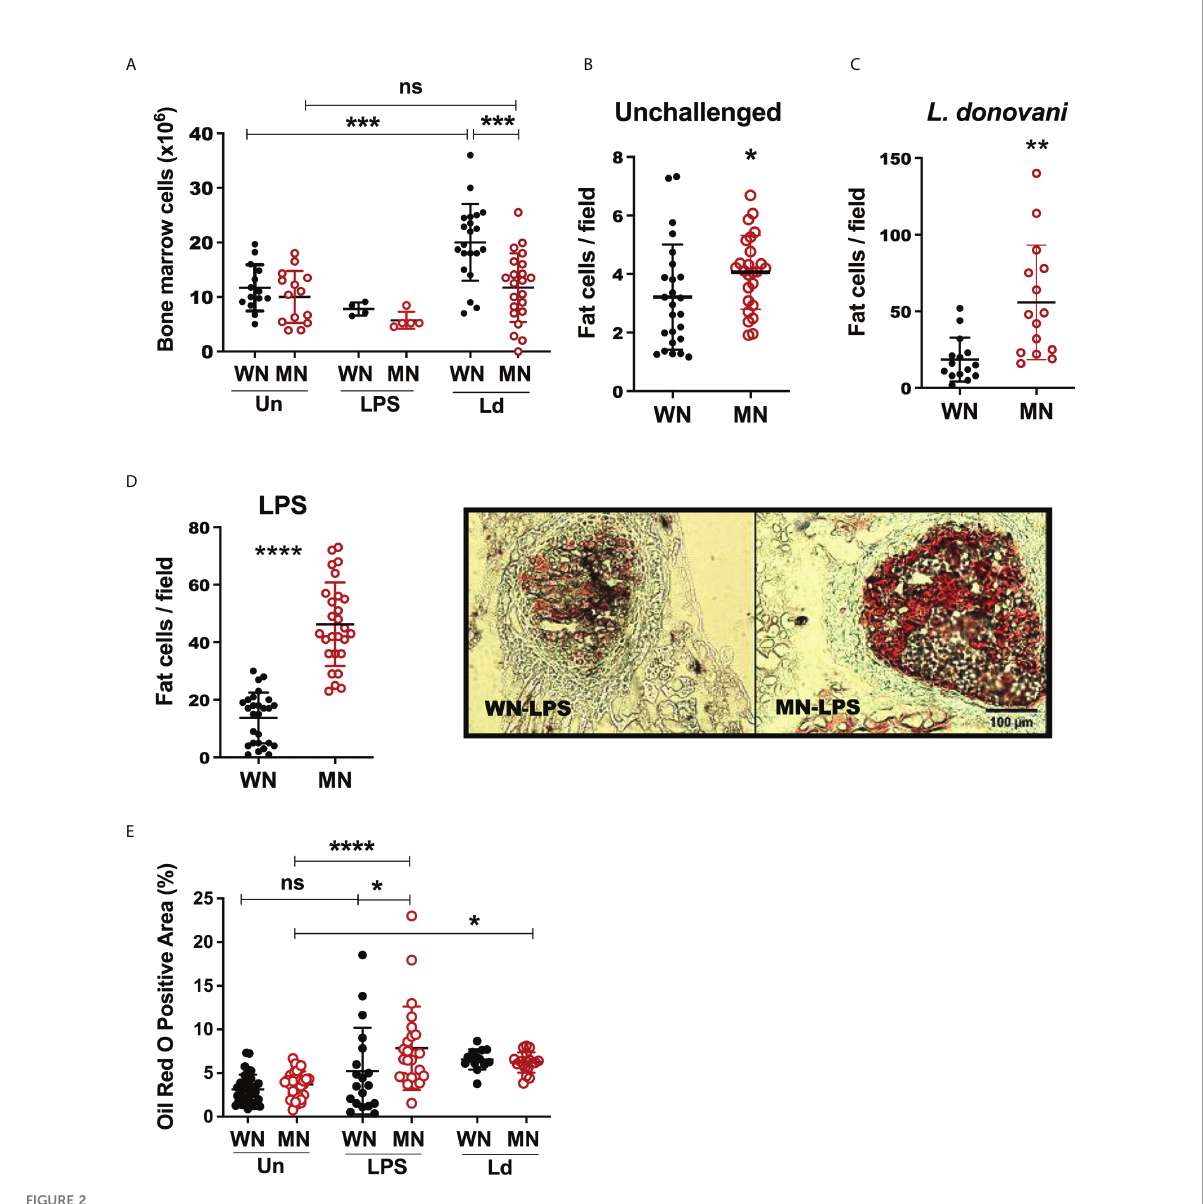
FIGURE 2 Malnutrition leads to increased bone marrow adiposity. Well-nourished (WN) or malnourished (MN) mice were challenged with lipopolysaccharide (LPS) or L. donovani ( Ld ) and compared with naïve unchallenged (Un) mice. L. donovani -challenged mice were evaluated at 72h post-challenge and LPS-challenged mice were evaluated at 24h post-challenge. (A) Number of cells in bone marrow from femur enumerated by microscopy. (B) Number of lipid- fi lled Oil-Red O positive (Oil-red O+) cells in sternum cryosections from uninfected mice. (C) Number of cells Oil-Red O positive (Oil-red O+) in sternum cryosections from L. donovani challenged mice at 72h post-challenge. (D) Left panel: Number of Oil-Red O+ bone marrow cells per fi eld in sternum cryosections from LPS-challenged mice. Right panel: image showing Oil- red O+ cells in hematopoietic centers observed in sternum cryosections from LPS challenged mice. (E) Oil-Red O+ area (hematopoietic centers + bone areas) in sternum cryosections. N=5 mice per group, 2 experiments. *p<0.05, **p<0.01, ***p<0.001, ****p<0.0001. ns, not signi fi